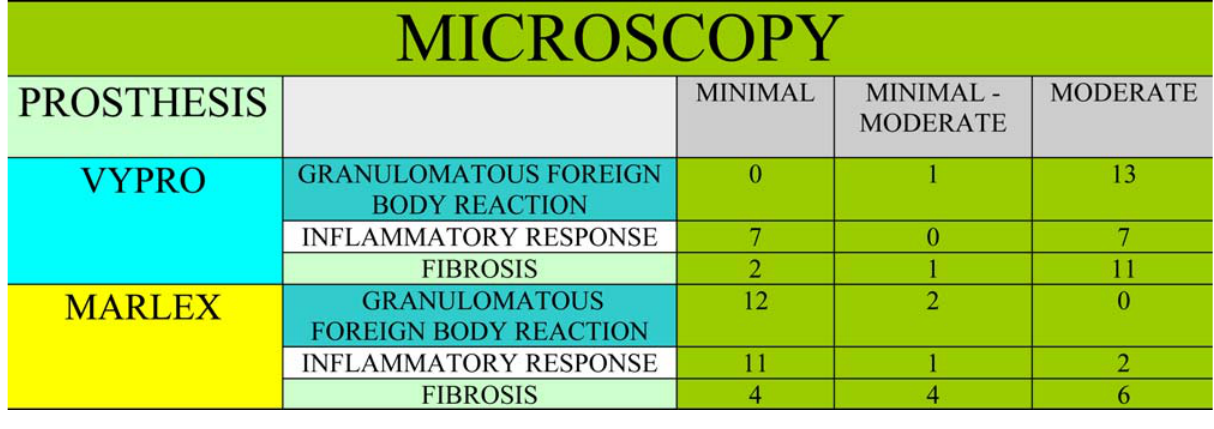
TABLE 1 - Microscopic analysis of Vypro and polypropilene mesh effects after abdominal wall